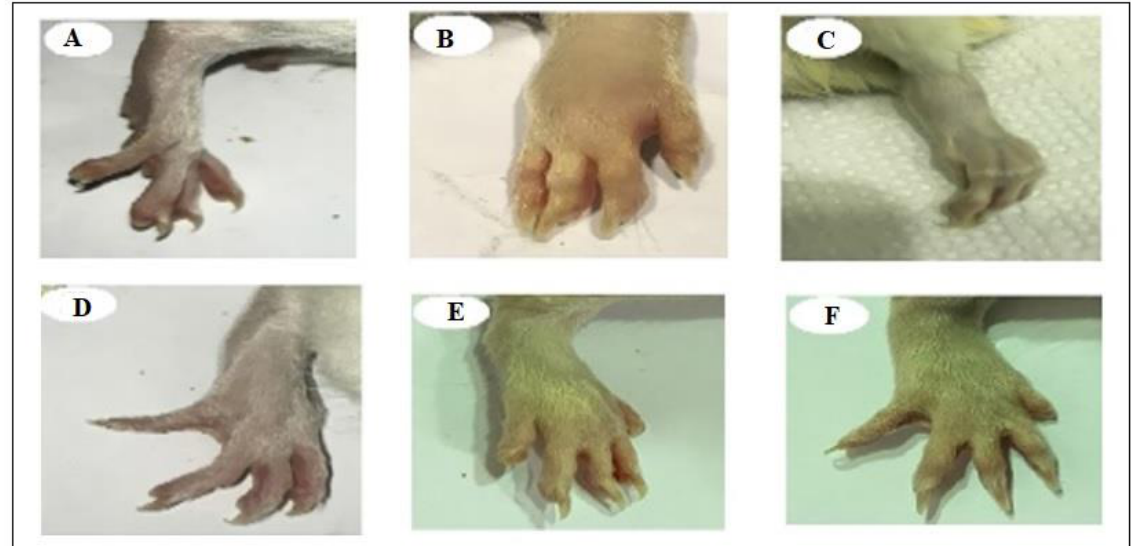
Figure 3. Effect of different nuts ’ oil on the morphological appearance of the back paw from all groups of rats. ( A ) (Control rats): shows normal appearance of the digits, and joint with no redness or swelling. ( B ) (AIA rats): shows severe swelling in the whole paw including the digits with deformities in all-paw digits. ( C ) (AIA + Walnut) and ( D ) (AIA + peanut): shows almost normal appearance of the back paws with reduced swelling and deformities in most of all digits. ( E ) (AIA + Cashew) and ( F ) (AIA + Hazelnut): shows improvement in the deformities of the digits but with the presence of some swelling.